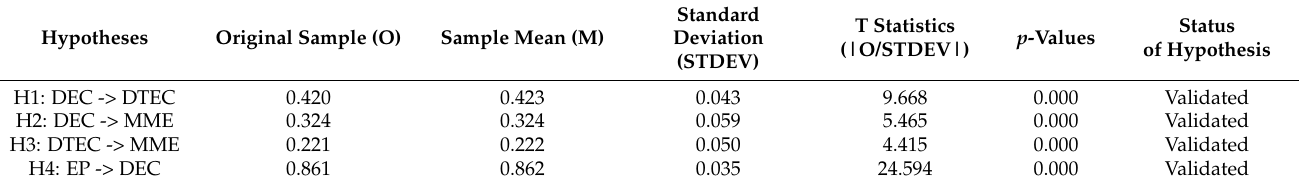
Table 6. The status of the